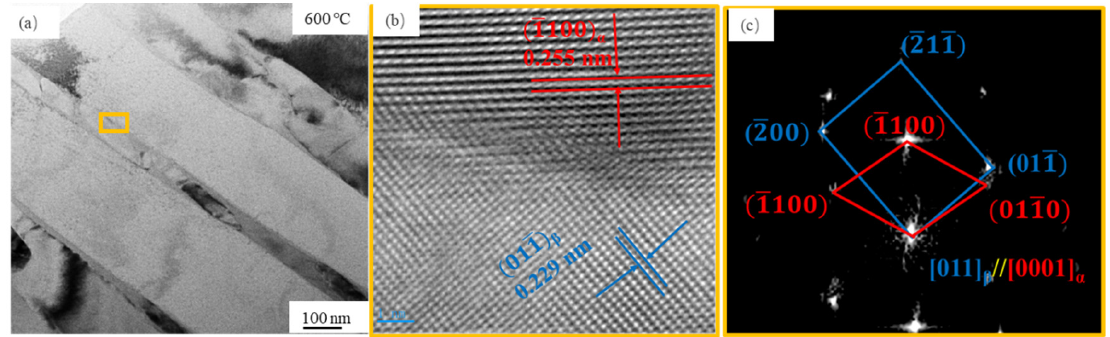
Figure 7. ( a ) Bright field image, ( b ) HRTEM IFFT image, and ( c ) FFT image of the Ti-6Al-4V alloy after LPBF at the powder bed temperature of 600 ◦